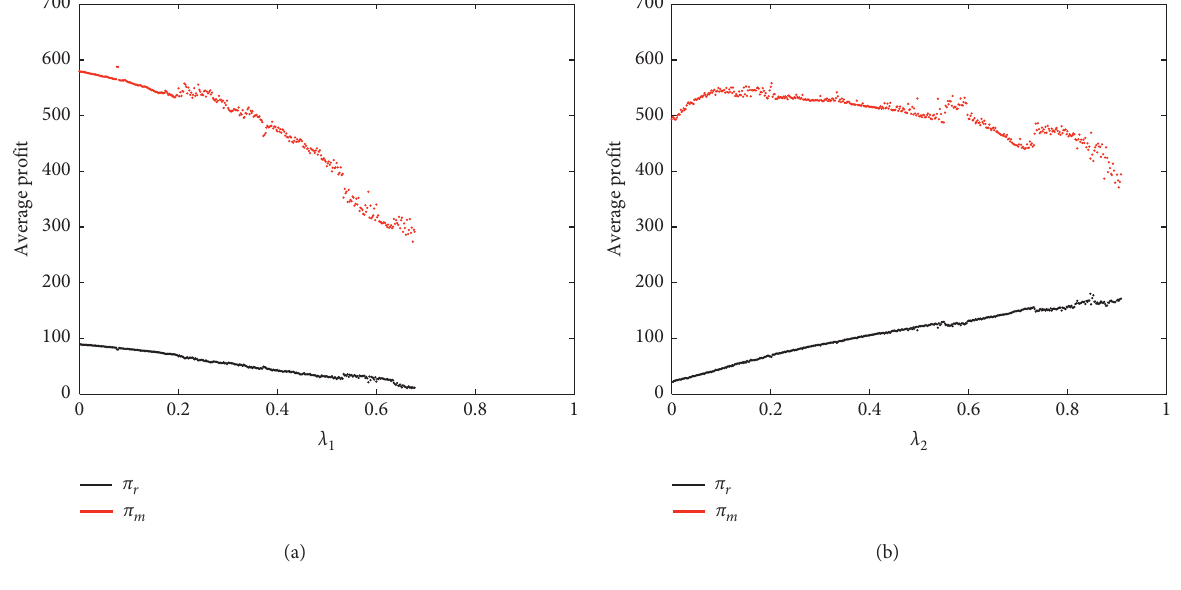
� 0 . 02 and α � 0 . 04. 1 2